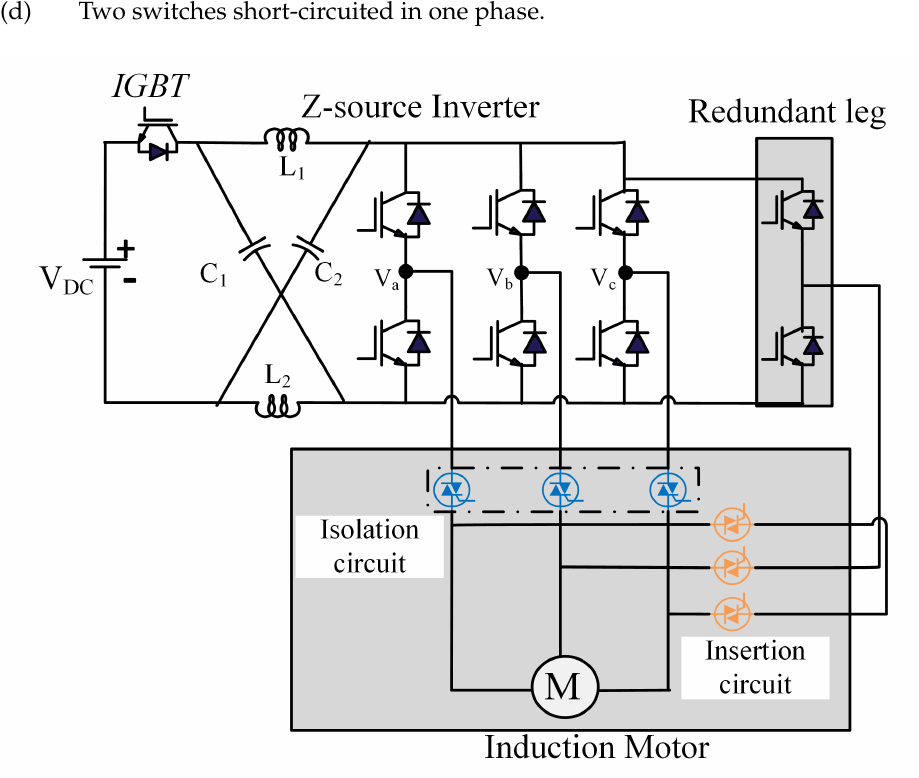
Figure 5. Circuit diagram of the Proposed